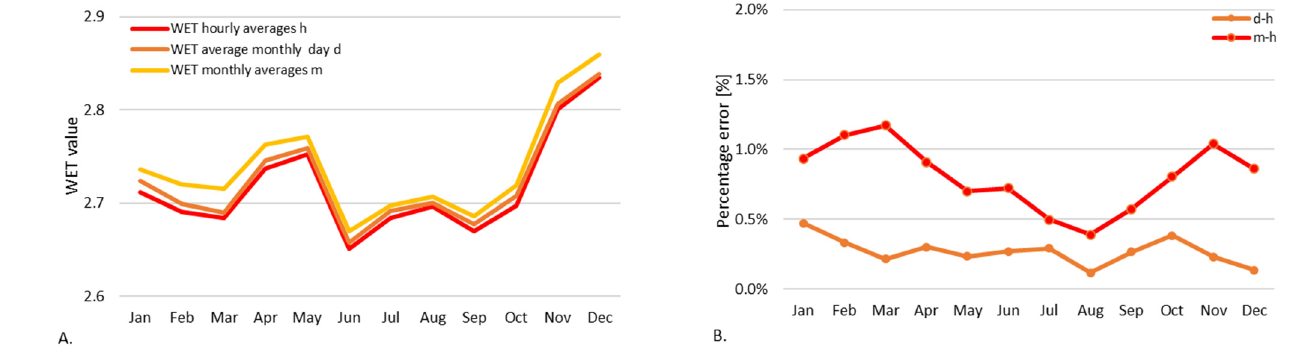
Figure 8. Singapore WET values ( A ) and percentage error ( B ).